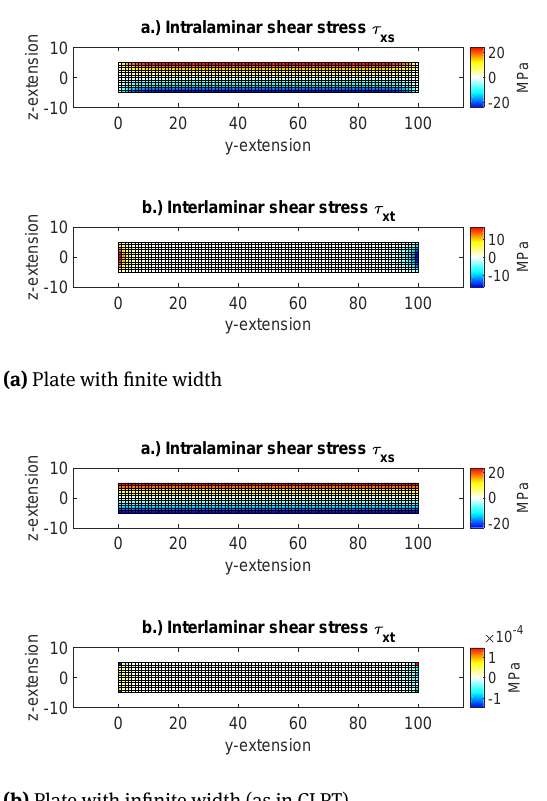
Figure 25: Shear stress distribution in a CFRP [0 4 ] laminate sub- jected to torsional loading. For better visibility, we have increased the laminate thickness to t = 10 mm . The results for the finite- width plates were produced using the code presented in [62] with deactivated periodicity boundary condition.